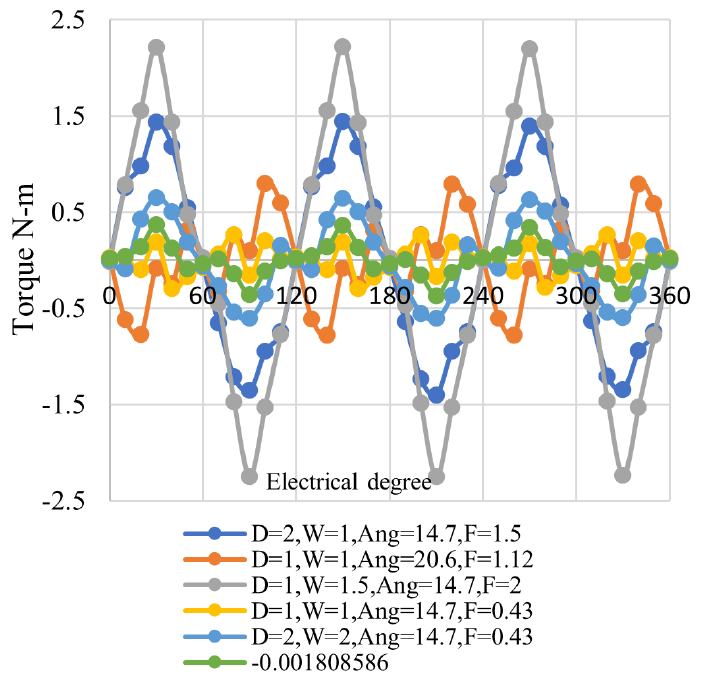
Figure 27. Results of hybrid (arc, flange, and notch).